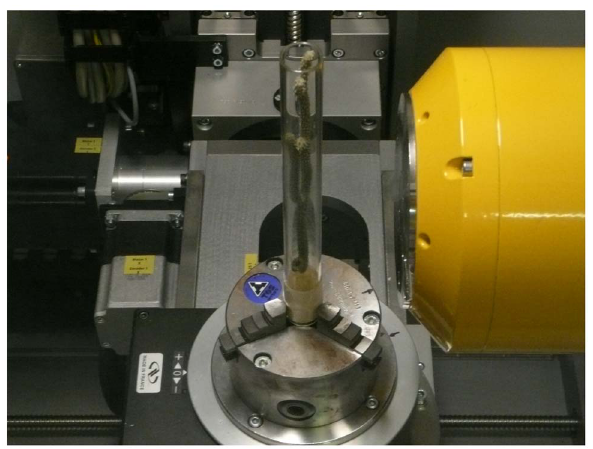
Figure 1. Specimen packed in a tube and placed within the micro-CT imaging device.